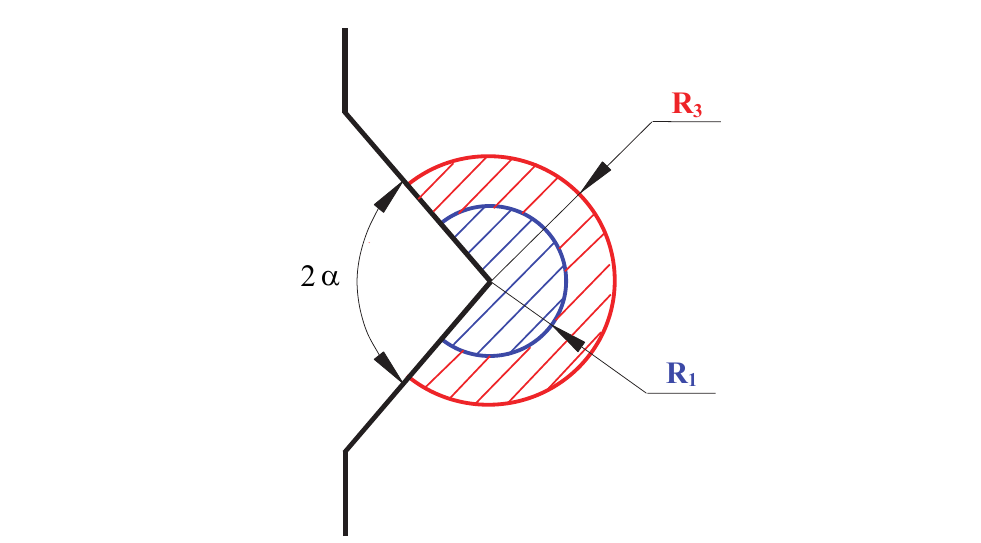
Figure 4: Control volumes for V-shaped notches under tension and torsion